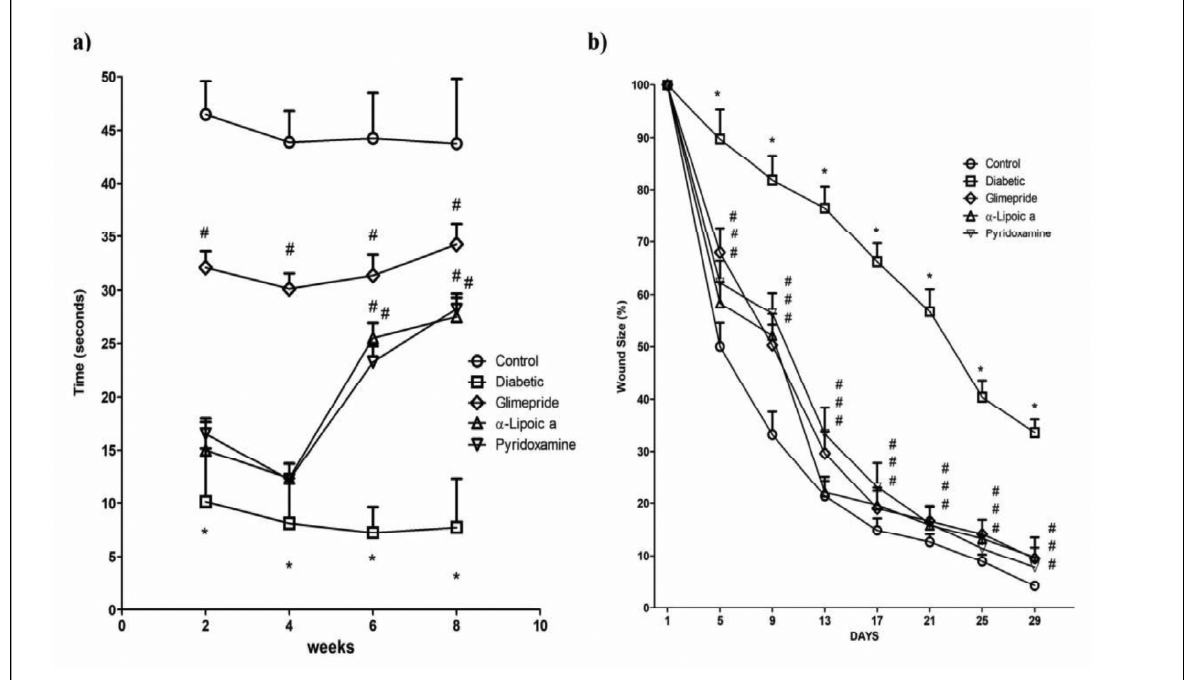
Figure 2: Effect of diabetes induction using STZ and treatment with glimepiride, lipoic acid and pyridoxamine for 8 weeks on: (a) hot plate latency, (b) wound healing Note: Data are presented as mean ± SEM ( n = 6-8); *significantly different from control group, # significantly different from diabetic group at p < 0.05 using Two Way ANOVA and bonferroni post hoc